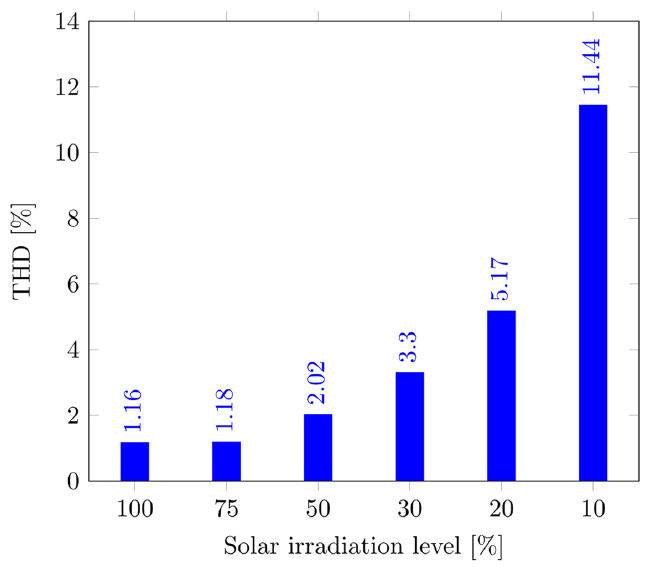
Figure 14. THD value of the grid current with the irradiation level using the proposed MFPC.